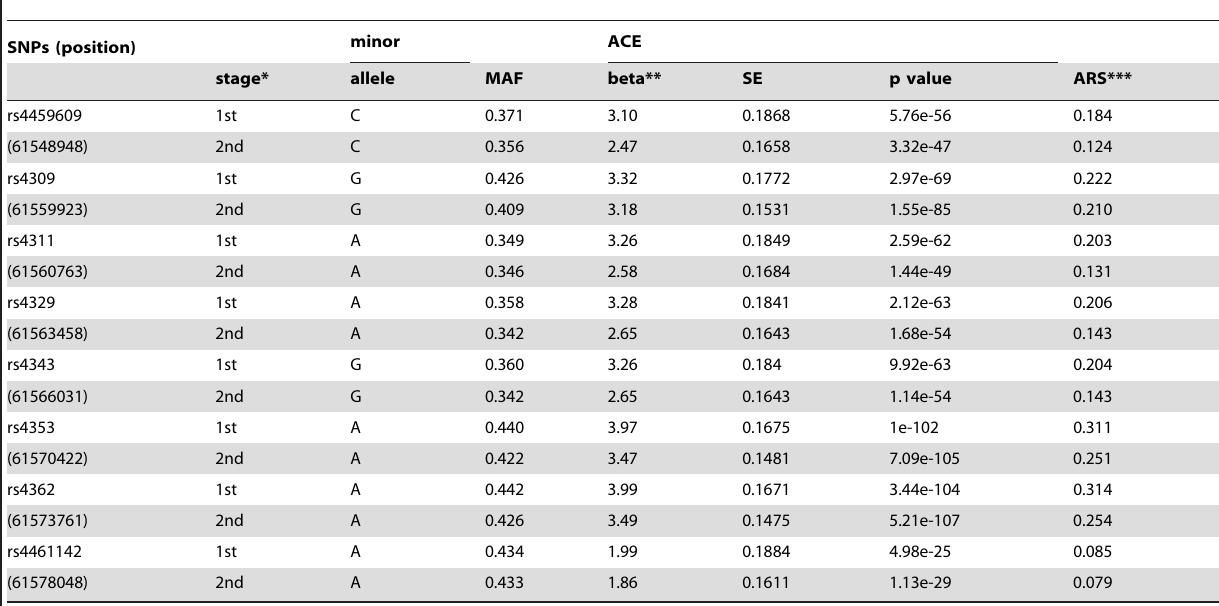
rs657152 rs500498